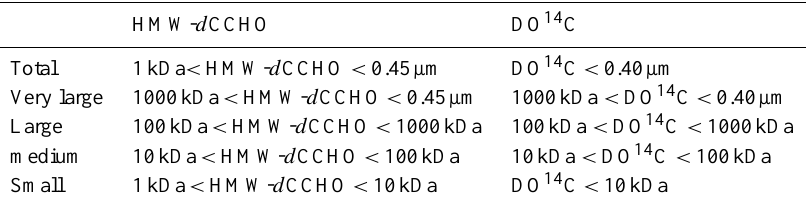
Table 1. Definition of size classes for fractionated high-molecular-weight (HMW, > 1kDa) dissolved combined carbohydrates (HMW- d CCHO) and dissolved organic carbon (DO 14